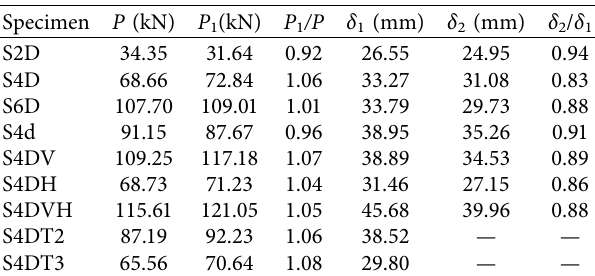
Table 3: Summary of test matrix and results.